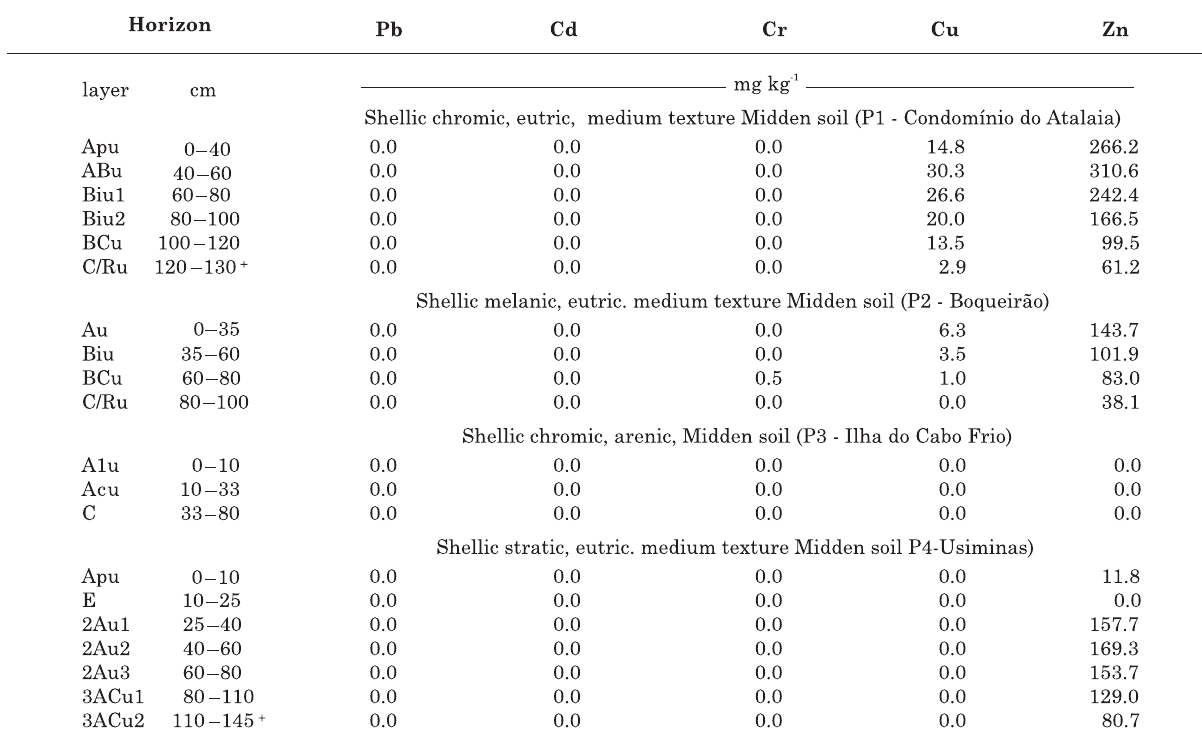
Table 6. Total contents of trace elements in the ADFE of the profiles P1, P2, P3 and